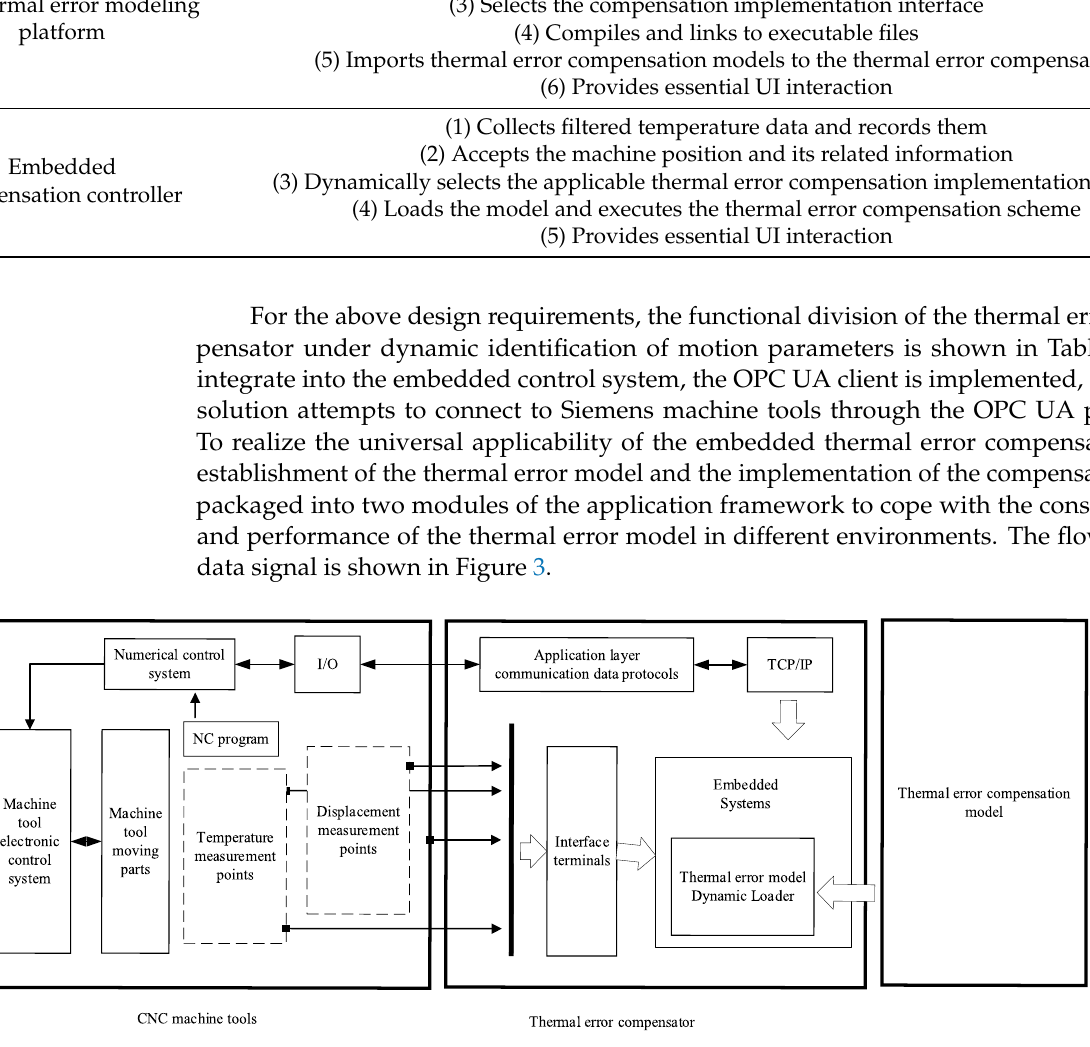
Figure 3. Thermal error compensator signal transmission flow diagram.